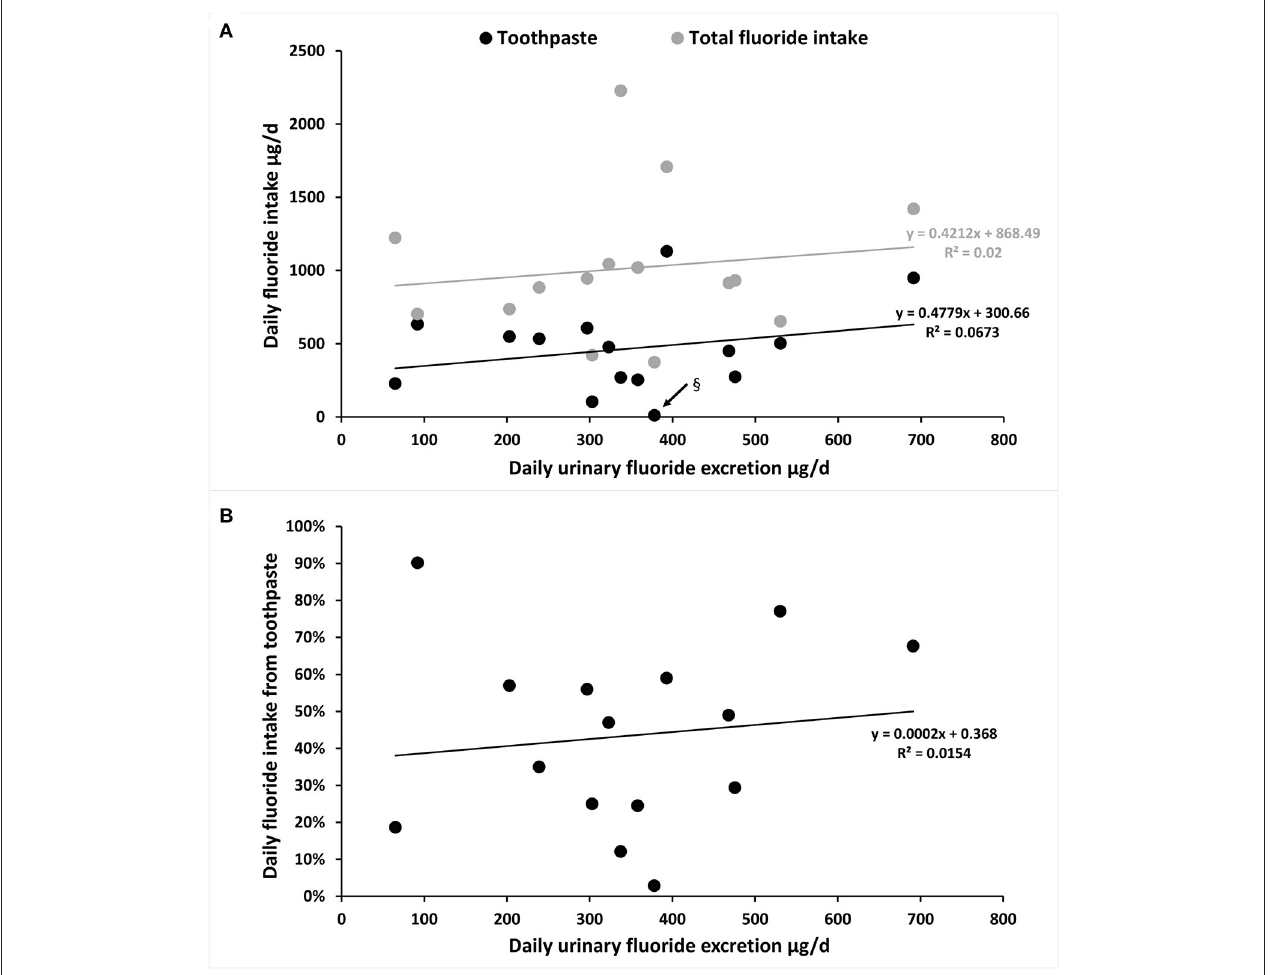
FIGURE 4 | Estimation of the mean DUFE ( µ g/day) in relation with the mean TDFI (diet and toothpaste) or only daily F intake from toothpaste in participants aged 1–7 years old and 20–35 years old [the highest dot in (A) ]. (A) The mean DUFE ( µ g/day) in relation with TDFI and daily F intake from toothpaste ( µ g/day). § Black arrow indicates the lowest value of F intake from toothpaste from Zohoori and Rugg-Gunn [40]: three toothpaste users among 28 in Darab (not the same region presented in Figure 2 ; Table 3 ). (B) The mean DUFE ( µ g/day) in relation with daily F intake from toothpaste